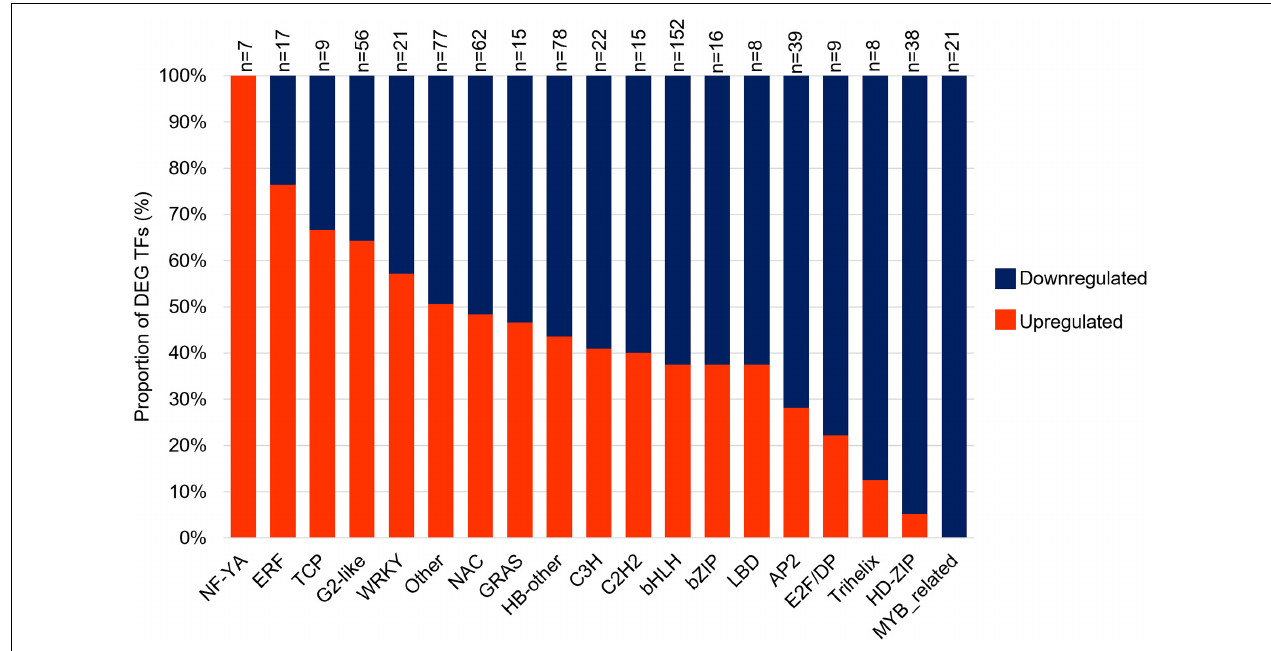
FIGURE 3 | Differentially expressed genes (DEGs) analysis of transcription factors (TF). TFs were classified into families of related genes, and the proportion of up and downregulated within each class of TF are shown. “n” indicates the total number of TF for each